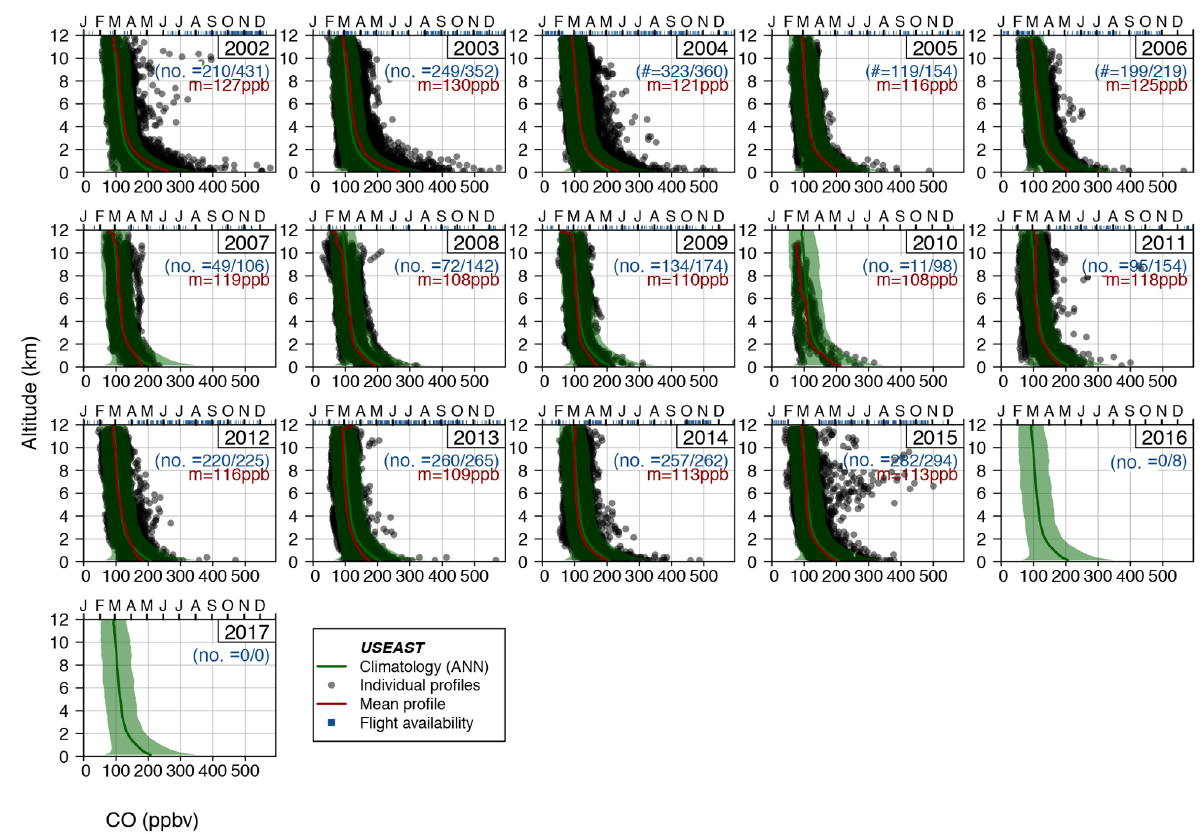
Figure 7. Same as Fig. 6 at the USeast